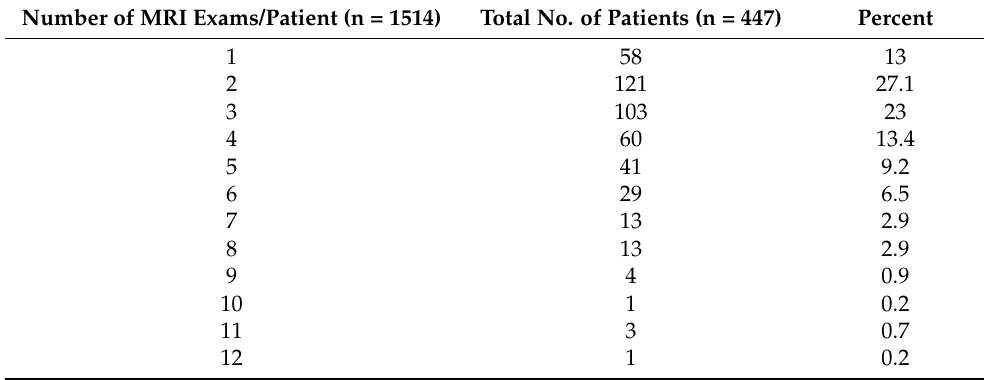
Table 3. Summary of the number of MRI examinations for the patient and their percentage.